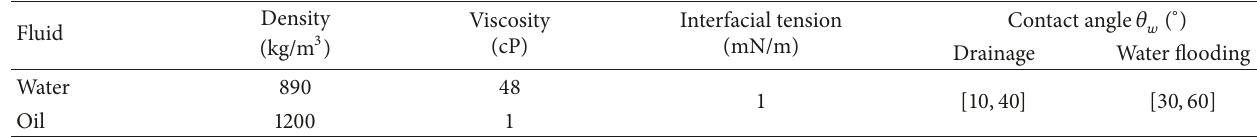
Table 3: Fluid properties used in the simulation at the temperature of 273